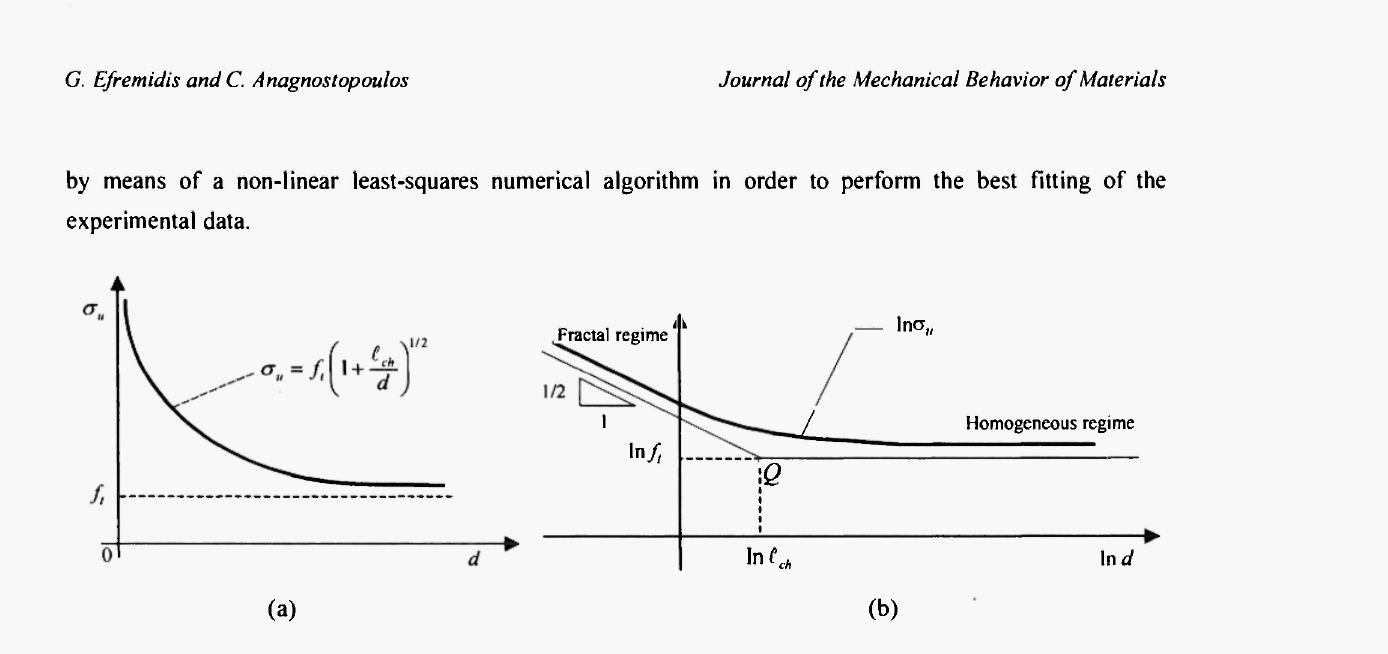
In the proportional diagram of MFSL it is shown that for large specimen sizes the nominal tensile strength a u tends to the asymptotic value f t